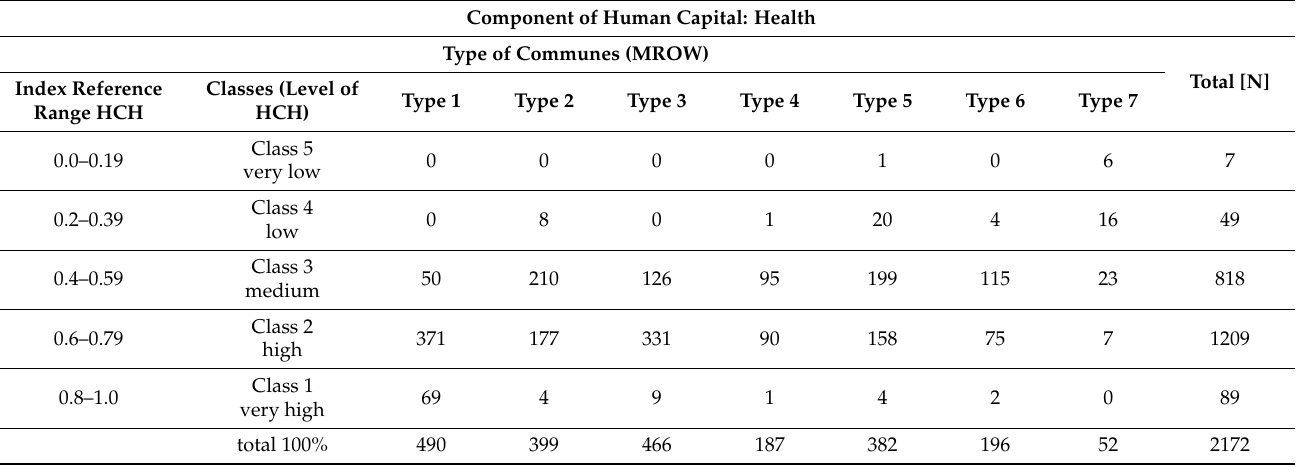
Table 9. The level of human capital in area of health [HCH] vs type of rural areas by MROW.